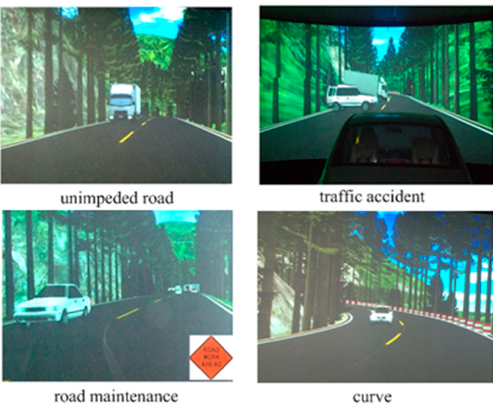
Figure 5. Parts of virtual driving scenes.